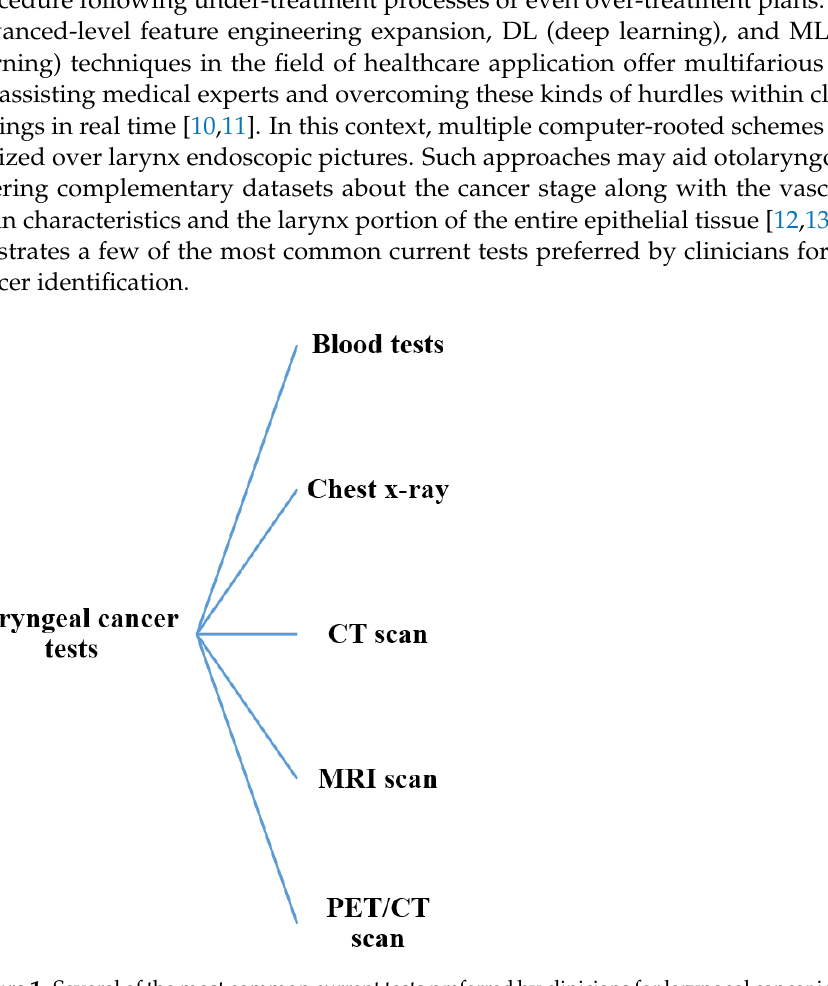
Figure 1. Figure 1. Several of the most common current tests preferred by clinicians for laryngeal cancer identification.